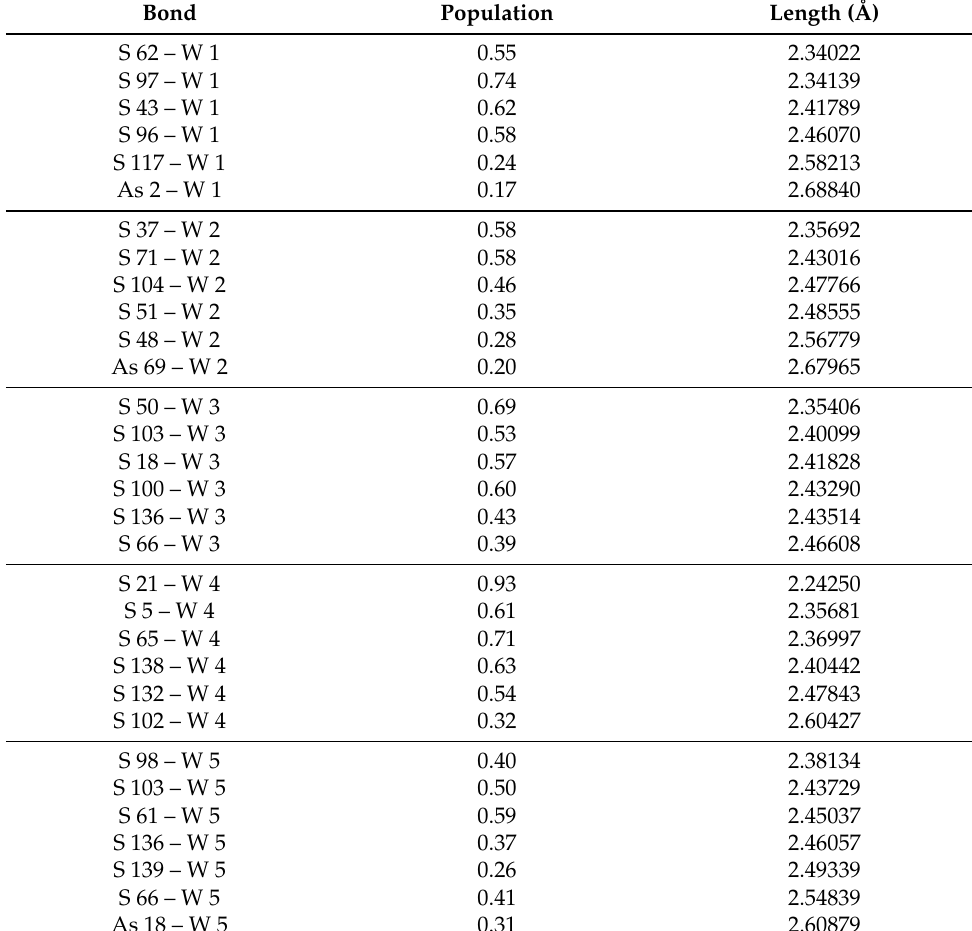
Table A12. Bond populations for mq-GOpt As 2 S 3